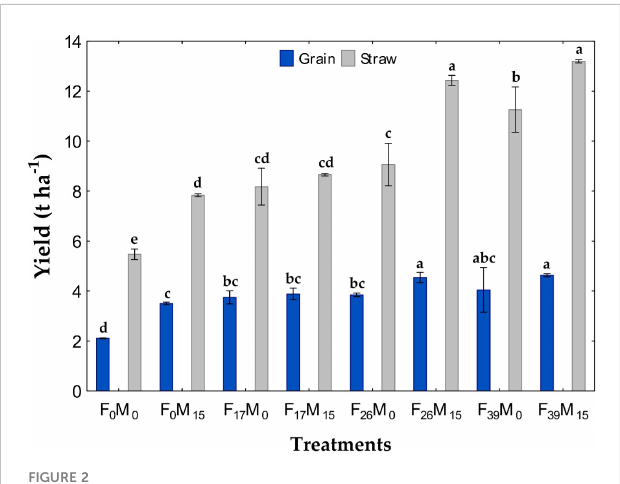
FIGURE 2 Wheat grain and straw yield as affected by P application from fertilizer (F) and/or farmyard manure (FYM). Fertilizer was applied at 0, 17, 26, or 39 kg P ha − 1 , and FYM was applied at 0 or 10 T ha − 1 with 0 or 15 kg P ha − 1 , respectively (FYM = 0.15% P). Treatment means with different letters are signi fi cantly different at p< 0.05. Data are shown as means ± SD ( n =